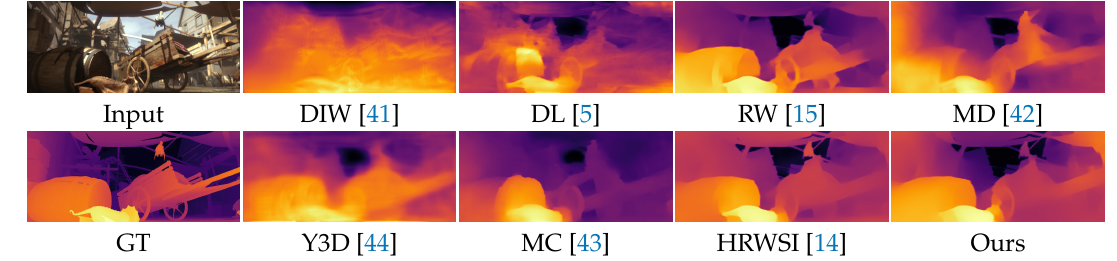
Figure 9. Qualitative results of different MDP methods.